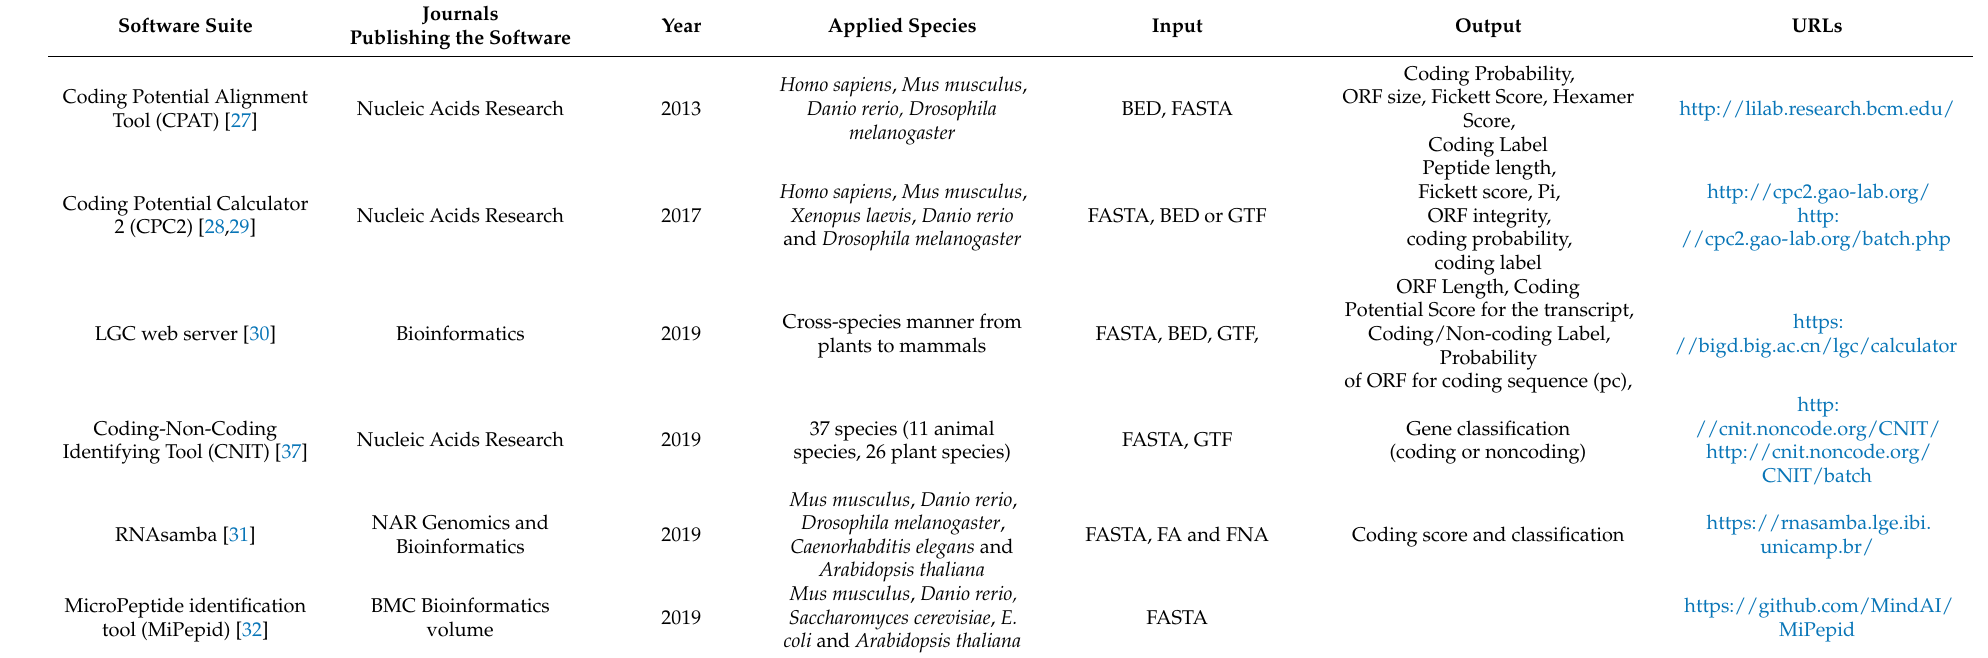
Table 1. List of computational tools for noncoding RNA analysis (accessed on 4 February